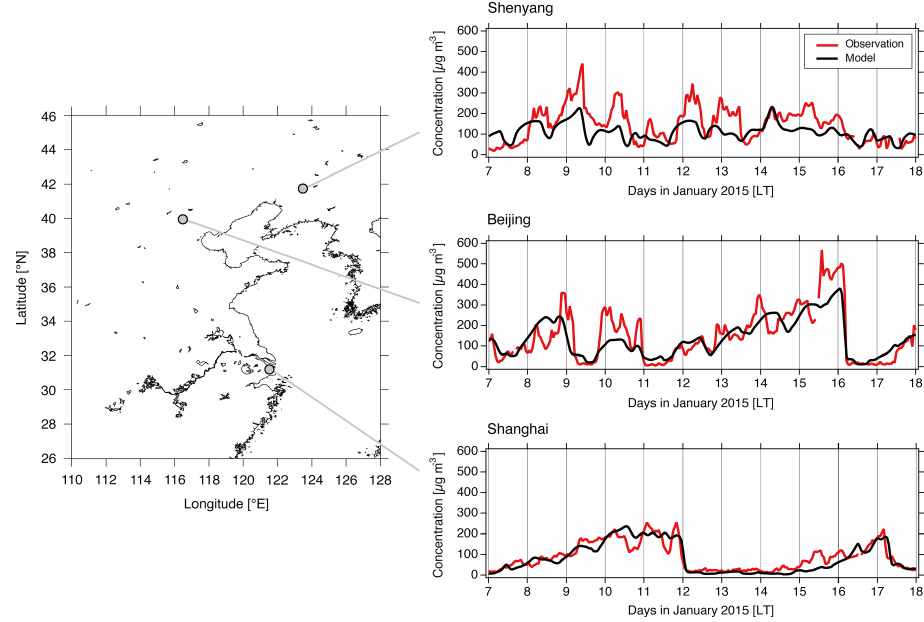
Figure 2. The temporal variation in PM 2 . 5 over China at Beijing, Shanghai, and Shenyang from 7–17 January 2015. The red lines indicate the observations by the BAMs at the US Embassy in Beijing and at the US consulates in Shenyang and Shanghai. The black lines indicate the base case